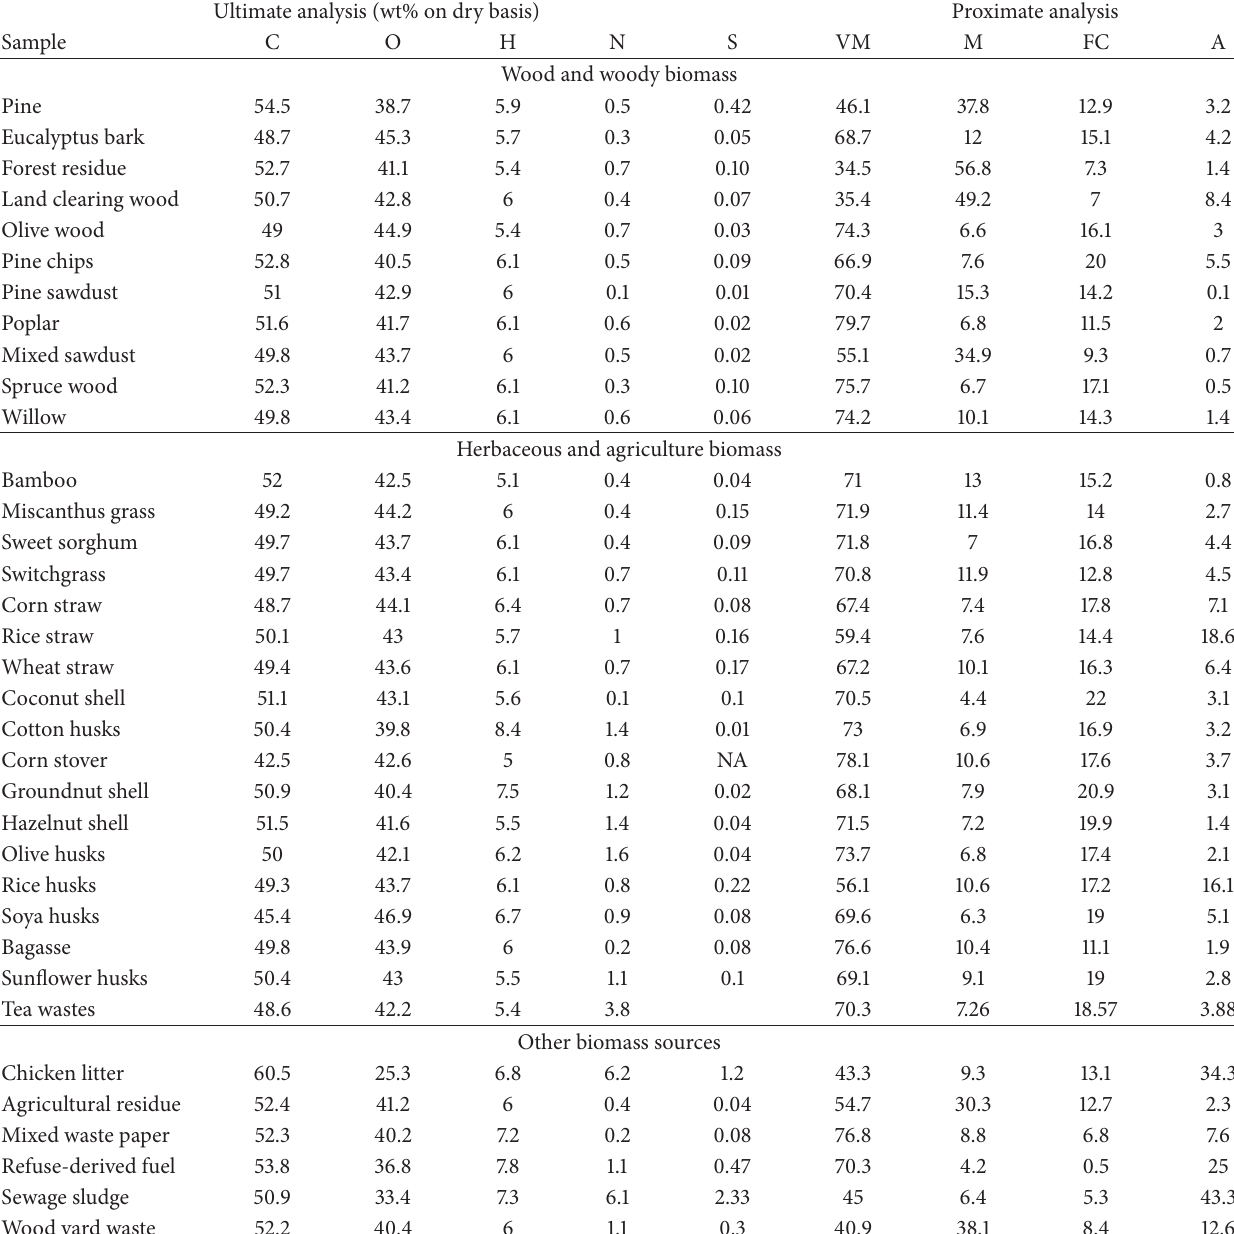
Table 4: Ultimate and proximate analyses of different biomasses